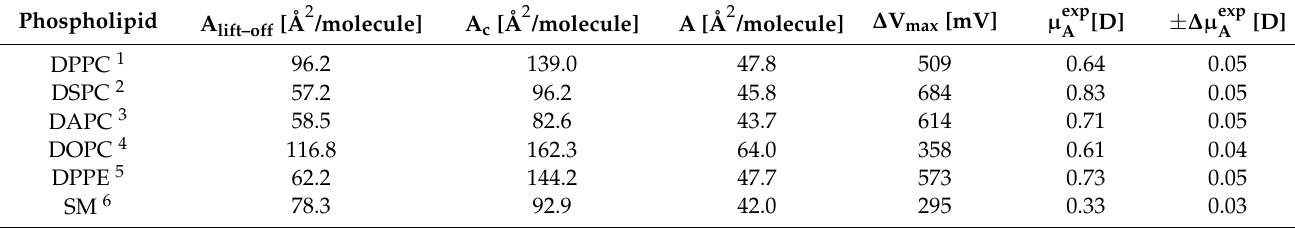
Table 1. Selected data read from surface pressure–area ( π –A) and electric surface potential–area ( ∆ V–A) experimental curves measured at 20 ◦ C, together with experimental apparent dipole moments µ exp obtained by exact differential method)—explanation in the